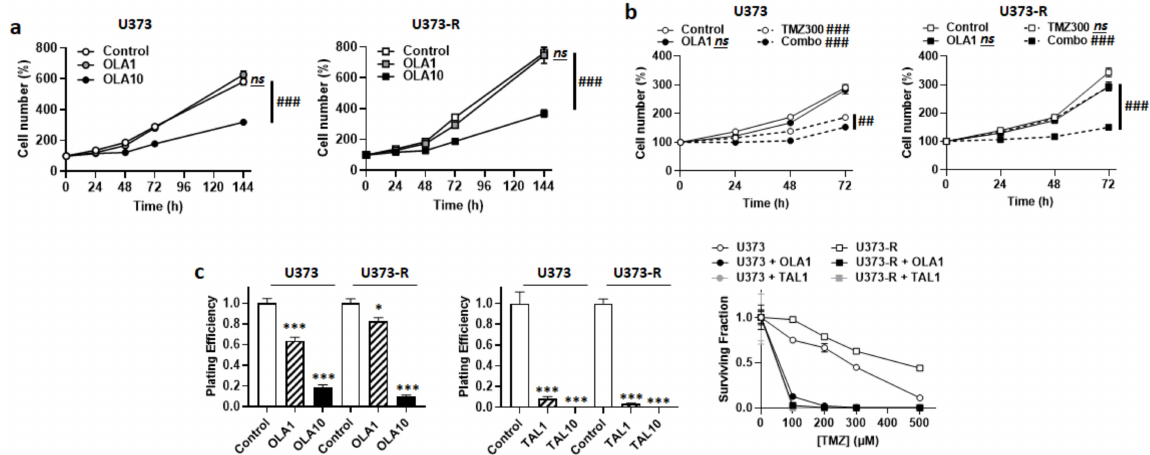
Figure 5. PARP inhibitors sensitize U373 and U373-R cells to TMZ. ( a ) Number of U373 (left; n = 4–8) and U373-R (right; n = 4–7) glioblastoma cells that were treated ± 1 µ M of PARP inhibitor olaparib (OLA1) or ± 10 µ M olaparib (OLA10) determined by direct counting over time. ( b ) Number of U373 (left; n = 12–16) and U373-R (right; n = 12–16) cells over time upon treatment ± 1 µ M olaparib ± 300 µ M TMZ300. ( c ) Clonogenic assays of U373 and U373-R cells that were pretreated for 72 h with increasing concentrations of TMZ ± OLA1 or OLA10, or TMZ ± 1 µ M talazoparib (TAL1) of 10 µ M talazoparib (TAL10). Displayed are the plating efficiency of TMZ-untreated cells ± olaparib (left; n = 6); the plating efficiency of TMZ-untreated cells ± talazoparib (middle; n = 6); and the surviving fractions (right; n = 5–6), where the data are normalized to the number of corresponding TMZ-untreated cells. All data are shown as means ± SEM. * p < 0.05, *** p < 0.005 versus olaparib-untreated corresponding cells; ## p < 0.01, ### p < 0.005, ns: p > 0.05 for whole curve comparison; by two-way ANOVA with Sidak’s post hoc test ( a – c right, d right) or one-way ANOVA with Dunnett’s post hoc test ( c left).